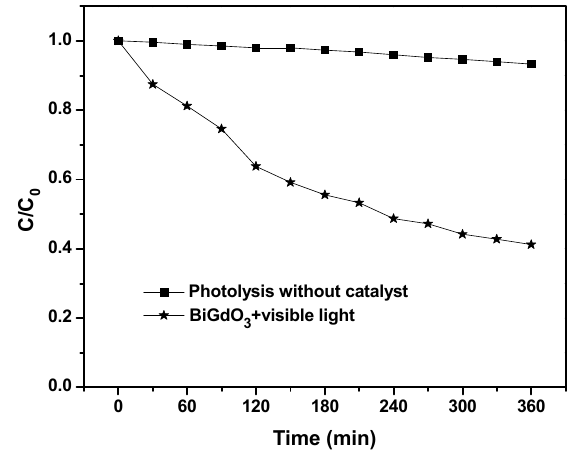
Figure 10. Photocatalytic activity of BiGdO 3 for degrading phenol under visible light irradiation.